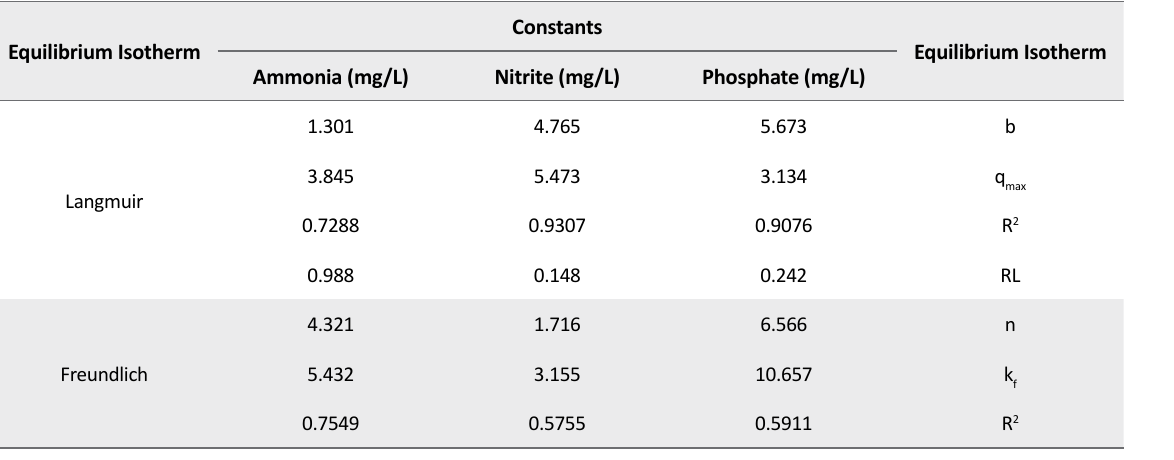
Table 4. Langmuir and freundlich